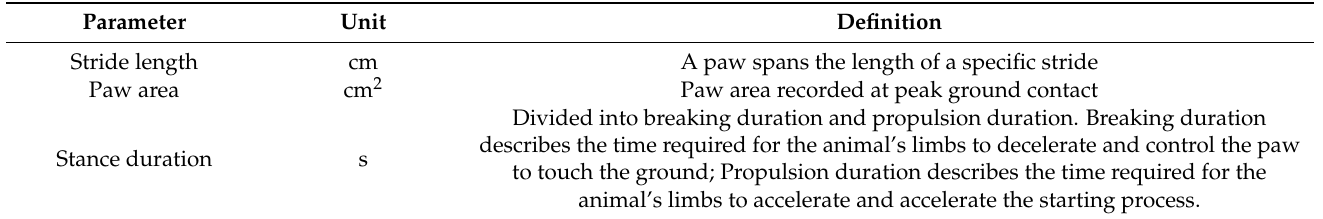
Table 2. Indices of digital